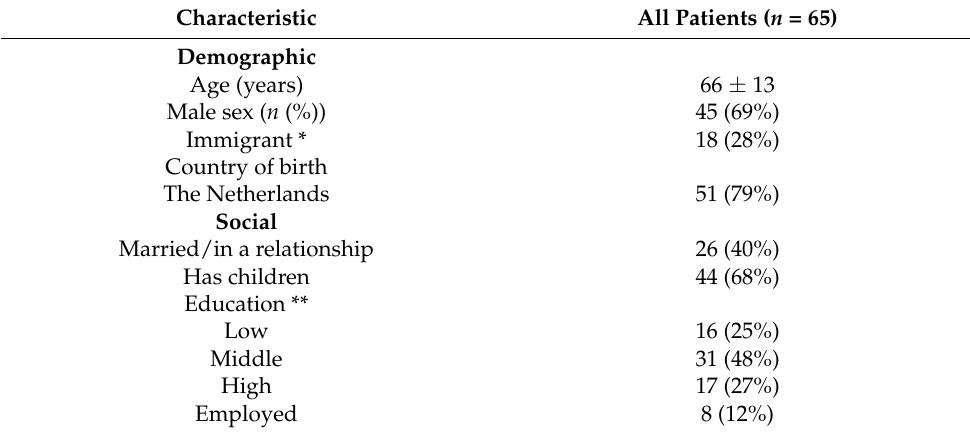
Table 1. Baseline characteristics of 65 hemodialysis